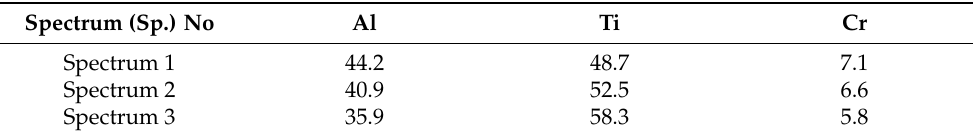
Table 3. Results of EDX analysis of different zones of the Ti-41Al-7Cr cladding layer labeled in Figure 3, at.%.